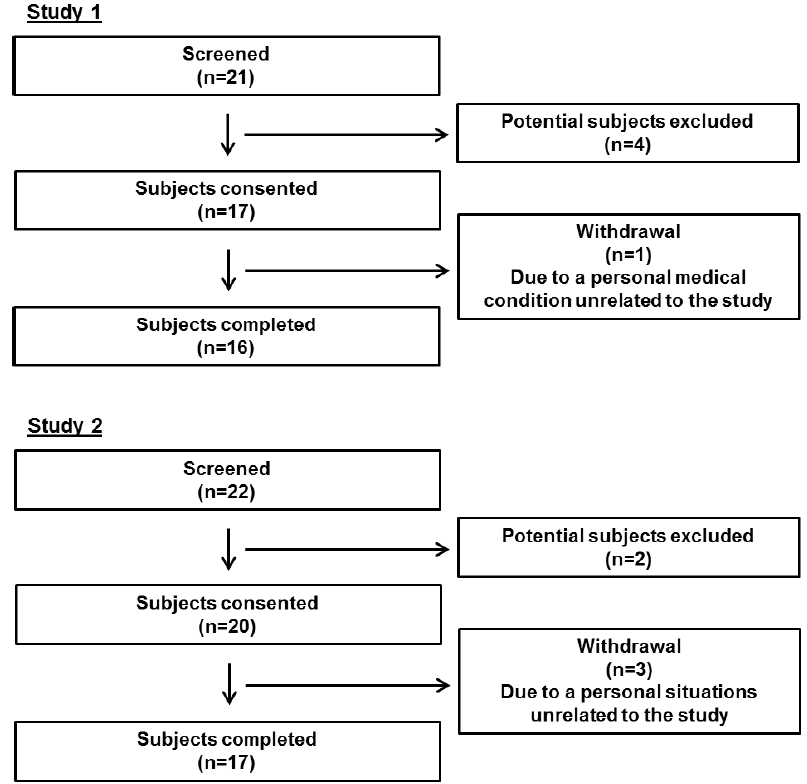
Figure 1. Consolidated Standards of Reporting Trials flow diagrams for study 1 and study 2.